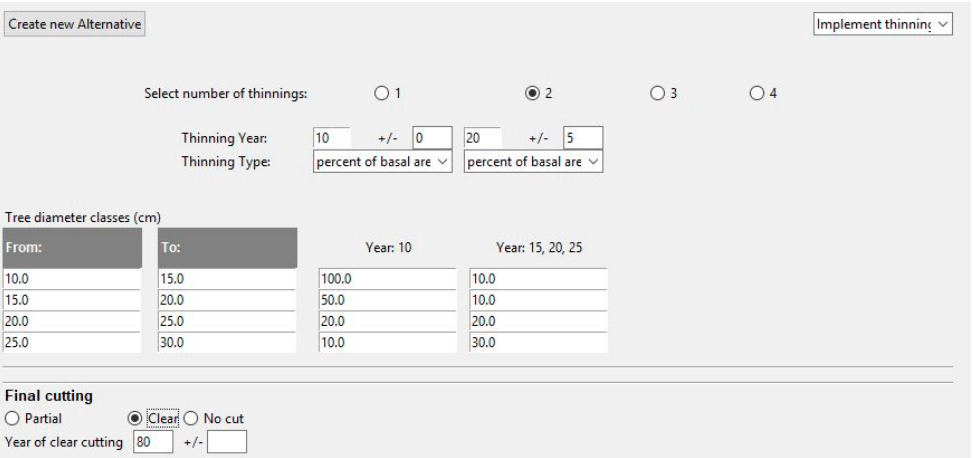
Figure 6. Management interface. The thinnings are defined in terms of the number of thinnings, the thinning year and thinning type, and also the diameter class range and the amount to cut. The final cutting section, at the bottom of the interface, o ff ers three options: partial cut, clearcut, and no